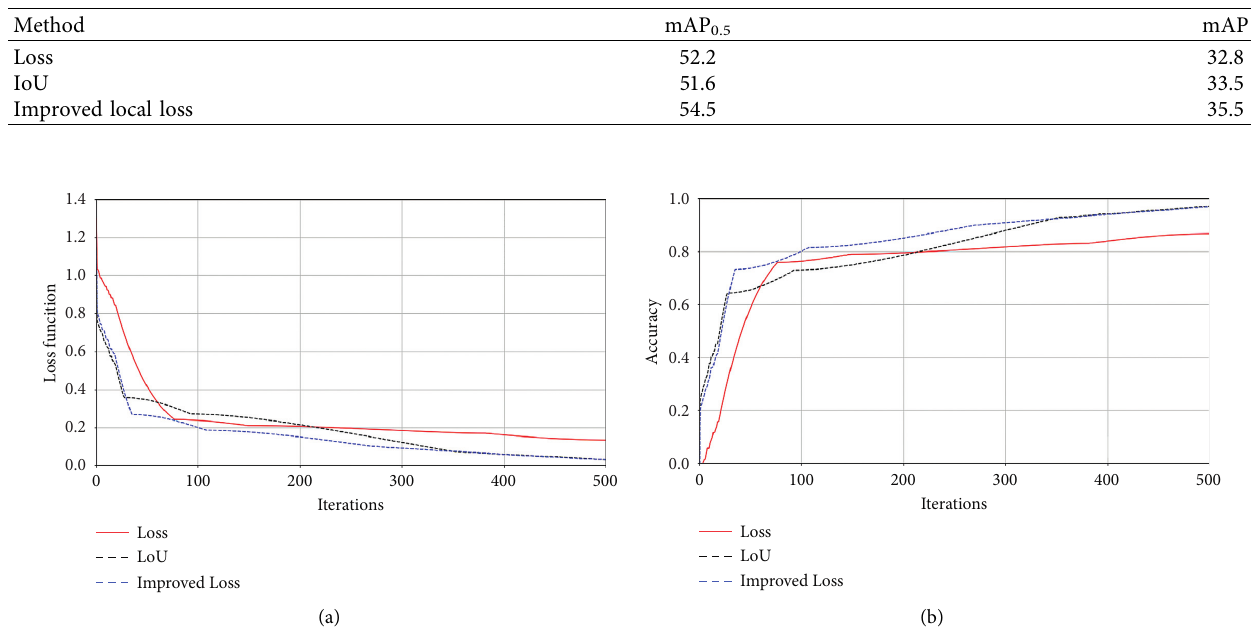
Table 3: Comparison test results of three loss functions.